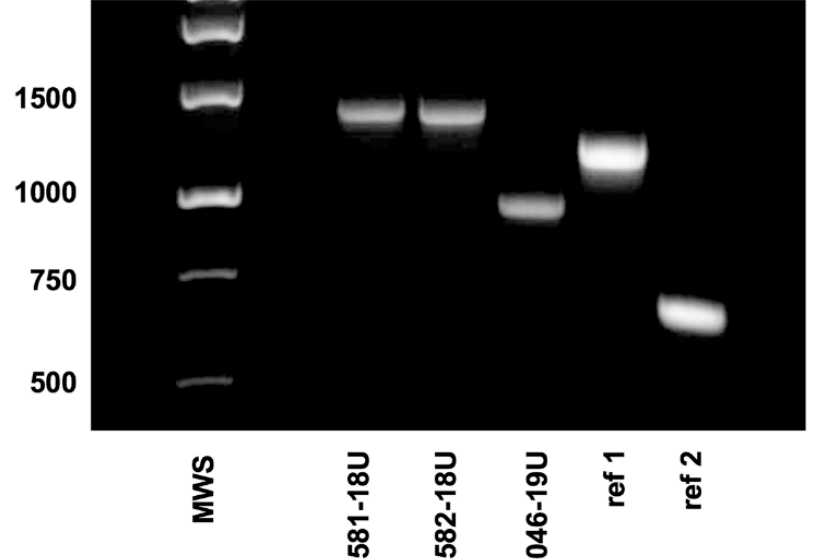
Figure 1. Polymerase chain reaction (PCR) analysis of the leukotoxin promoter region of A. actinomycetemcomitans strains 581-18U, 582-18U and 046-19U. As controls, DNA from a strain with a complete, full-length leukotoxin promoter (ref 1) and from a strain with a JP2 genotype promoter (530-bp deletion; ref 2) was amplified. Sizes (bp) of selected bands in the DNA molecular weight standard (MWS) are indicated. Table 1. The proportion of A. actinomycetemcomitans ( Aa ) in the subgingival plaque samples was quantified by cultivation of the samples on blood agar plates (total viable count (TVC)) and on Aa –selective plates (TBV agar). TVC per Sample Sample,